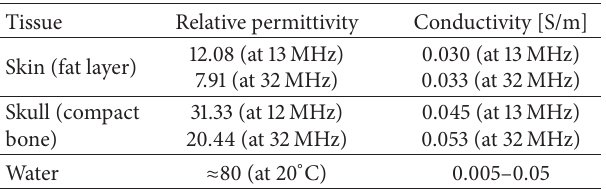
Table 3: Dielectric properties of the tissues and water